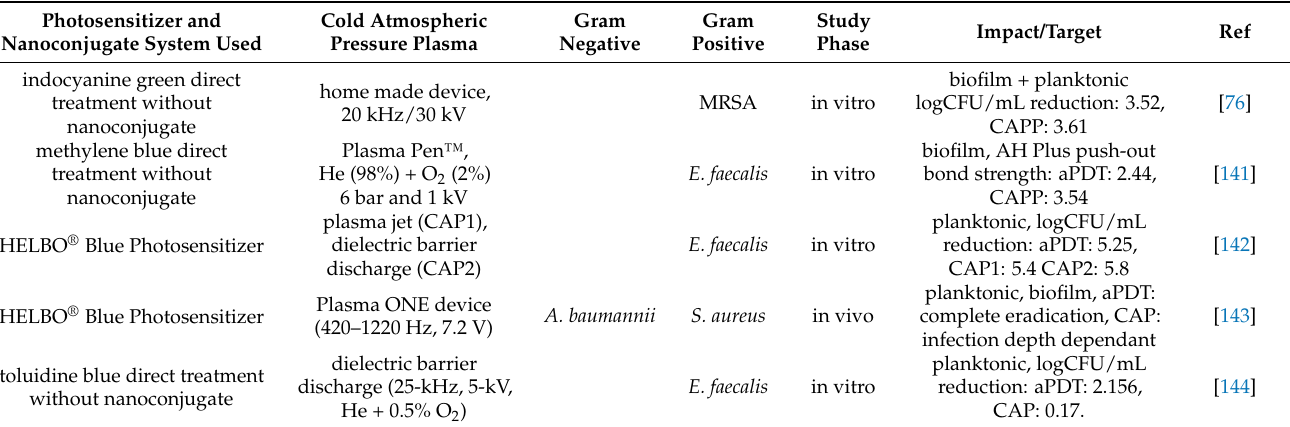
Table 6. Antibacterial photodynamic therapy in combination with cold atmospheric pressure plasma